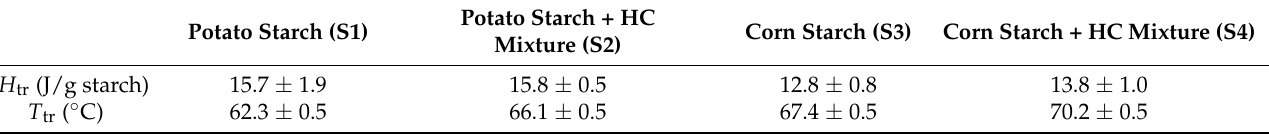
Table 4. Thermodynamic profile ( ∆ H transition and T transition ) of thermally induced transitions of starch suspensions without/with HC mixture (8% HPMC and 4% xanthan